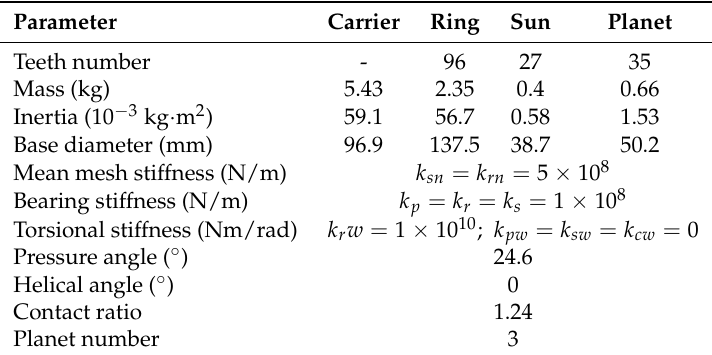
Table 1. Parameters of the planetary gear for simulation.